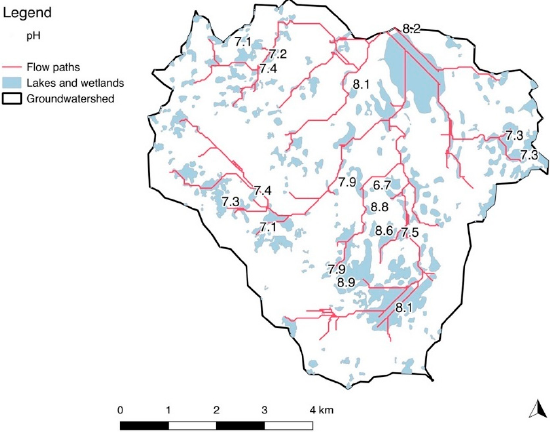
Figure 8. Groundwater flow path lines (in red) for the study area with mean pH measurements shown for sampled lakes and wetlands. Lengths of groundwater flow paths were also compared with average specific con- ductance measurements (Figure 9) and showed a statistically significant although weak relationship (R 2 = 0.39, p = 0.01) (Figure 10). Specific conductance appears to be larger in lakes and wetlands that have longer upgradient flow paths, although there are a few ex- ceptions. A few lakes (e.g., Augusta Lake and Horn Lake) that lie near the beginning of flow path lines have a relatively large specific conductance. In addition, unnamed ponds in the northwest portion of the study area lie at the middle of flow paths but have the lowest specific conductance measurements sampled in the study area (Figure 9).